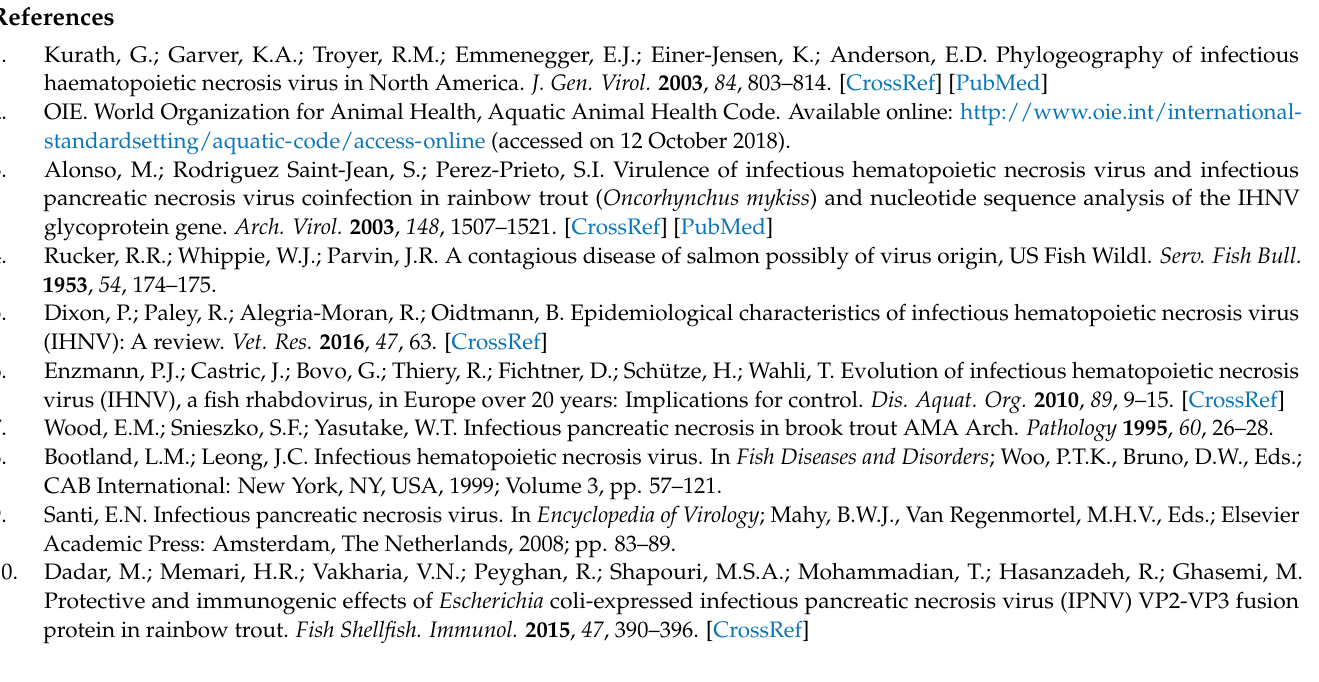
Figure S1: Cytotoxicity analysis of CSP to CHSE-214